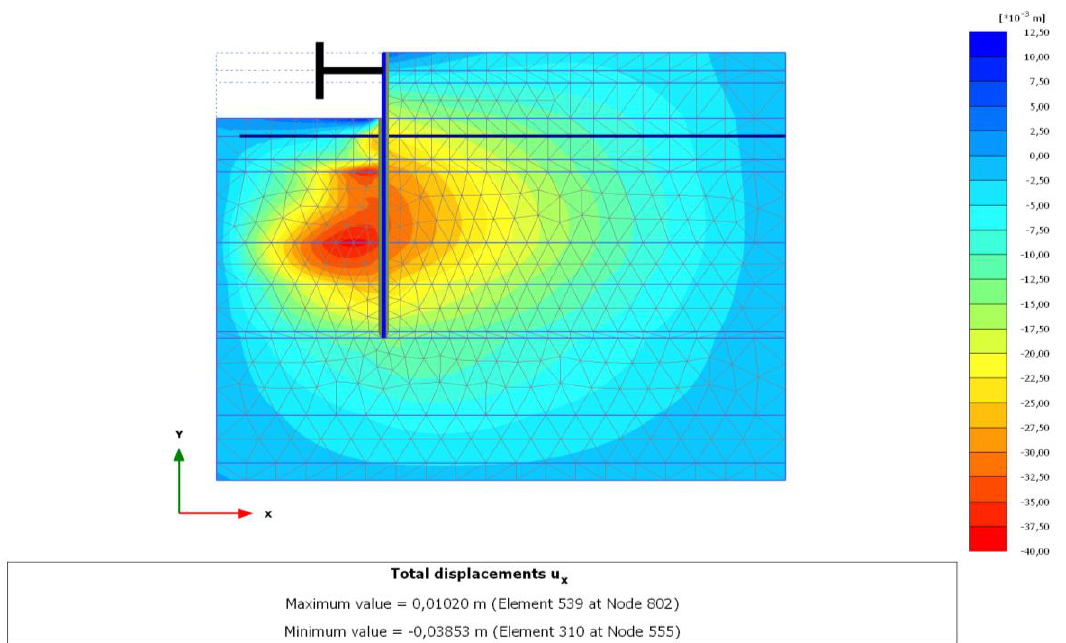
Figure 6. Displacement profile along X